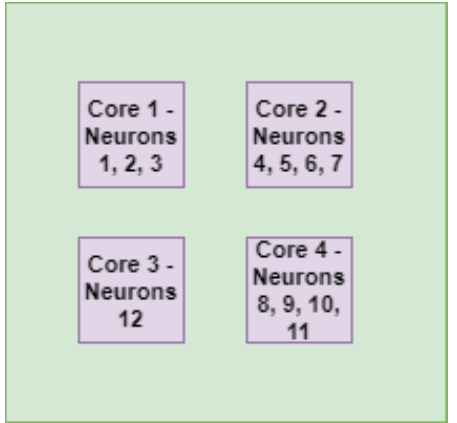
Figure 7. Level-2 mapping for four-cores architecture using multilevel mapping